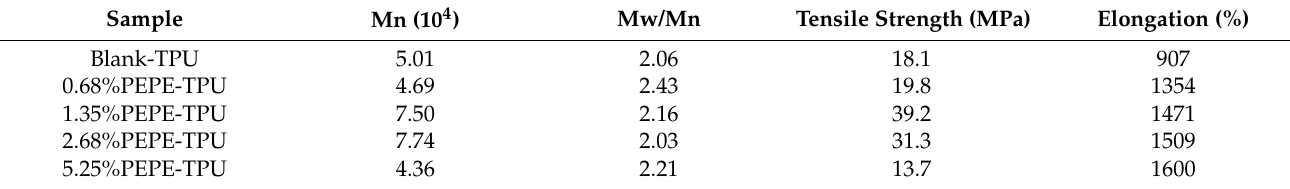
Table 2. Tensile strength and elongation of flame-retardant TPU with